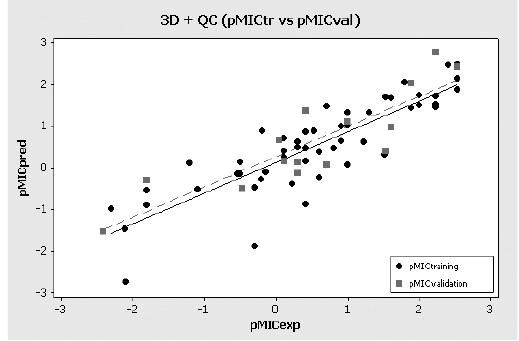
Figure 3. The experimental vs. predicted pMIC values using MLR method.